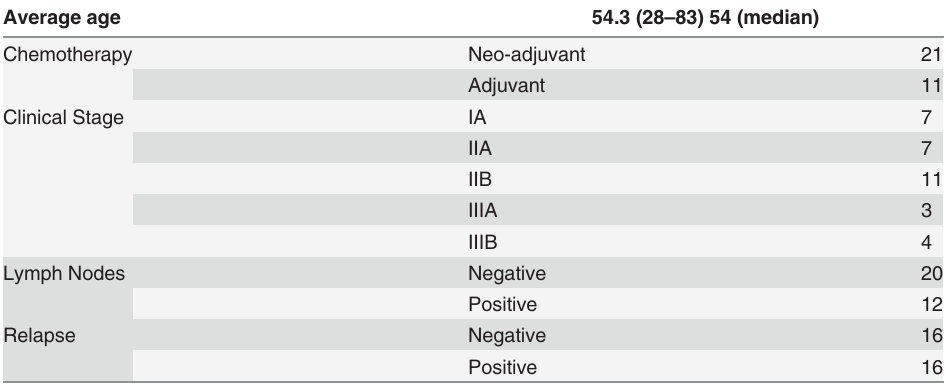
Table 3. Clinical information of triple negative breast cancer.